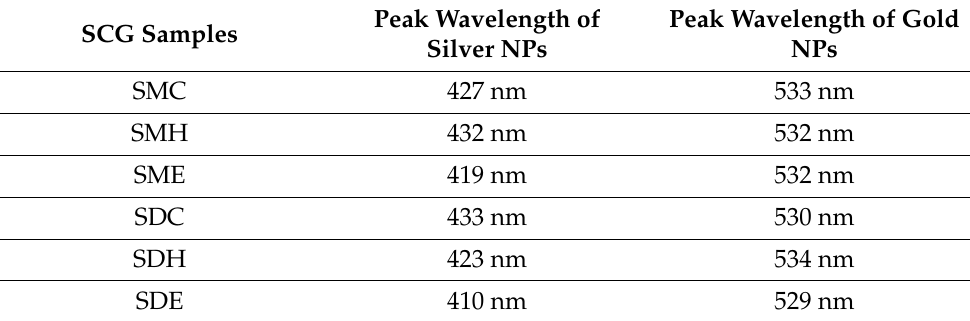
Table 3. Peak absorption wavelength of nanoparticles (NPs) prepared with 0.5 mL of spent coffee ground (SCG)-derived extract per 30 mL